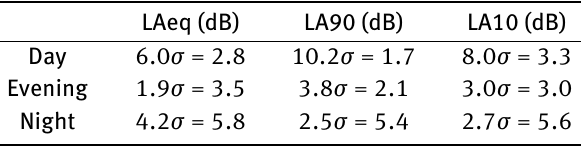
Figure 7: Shows a rurally located monitoring station, Case Study B, next to a major trunk road